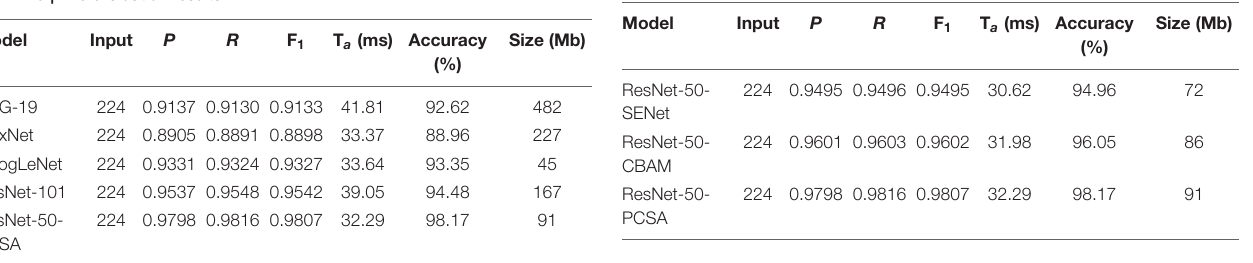
TABLE 5 | The results of PCSA compared with SENet and CBAM.